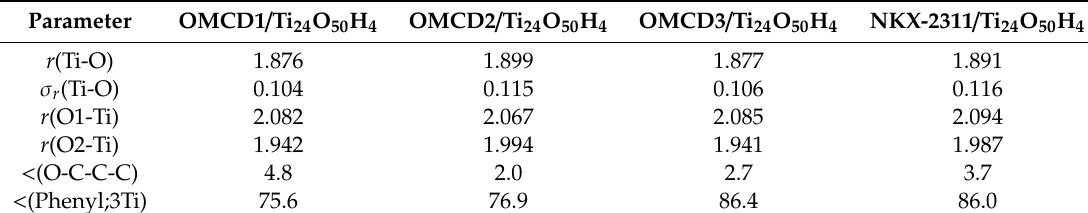
Table 4. The structural parameters of the model system consisting of the Ti 24 O 50 H 4 clusters with an adsorbed dye molecule, and of the bare cluster, obtained after geometry optimization by DFT/B3LYP/LANL2DZ in ethanol. Geometrical parameters describing the adsorption modes: bond lengths (in Å), the torsion angle of the carboxyl group relative to the indolinium plane, and the dihedral angle defined by the indolinium plane and the plane of the three neighbor Ti atoms on the cluster surface (both in deg).